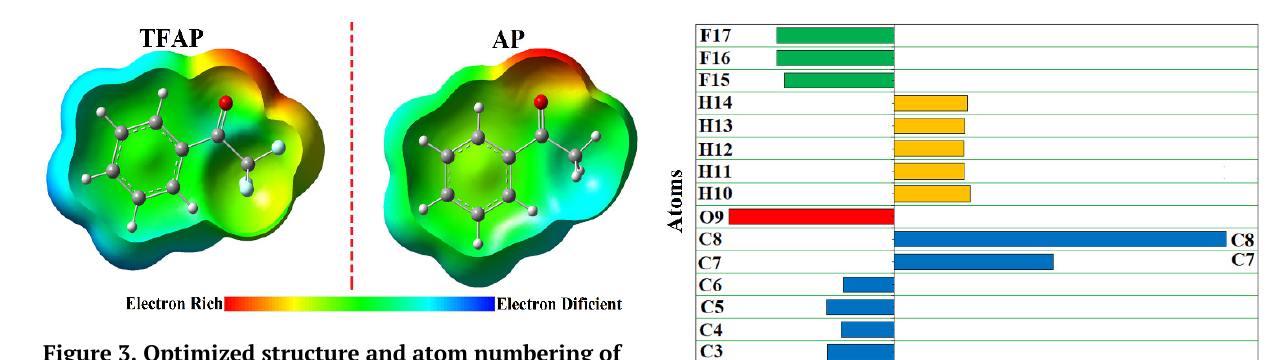
Figure 3. Optimized structure and atom numbering of TFAP